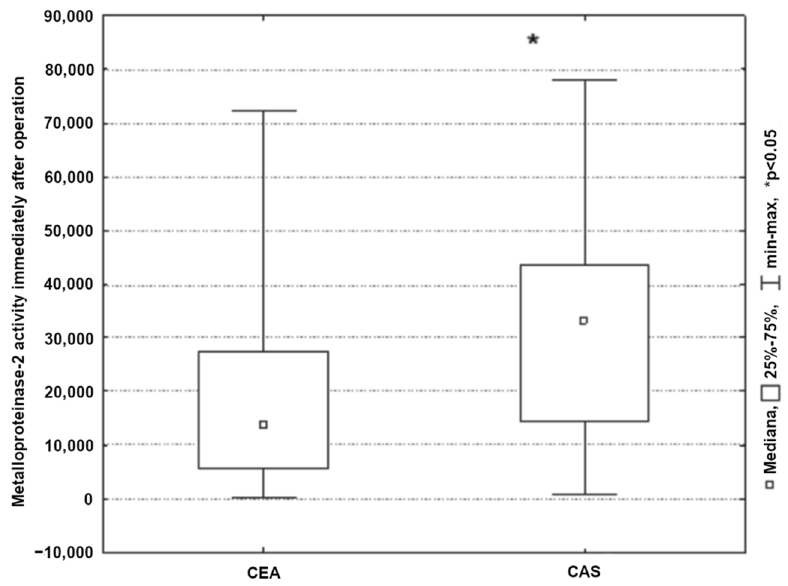
Figure 4. Changes of MMP-2 activity immediately after CEA/CAS procedure.